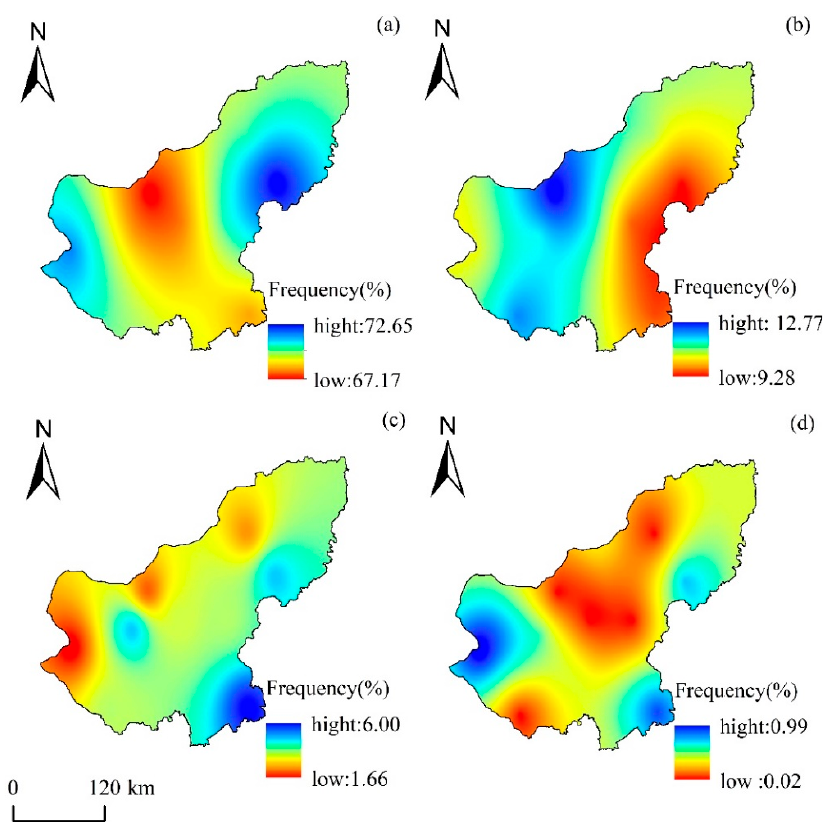
Figure 3. Distribution of the drought frequency in different grades from 1969 to 2018. ( a ) Normal, ( b ) mild drought, ( c ) moderate drought, and ( d ) severe drought.